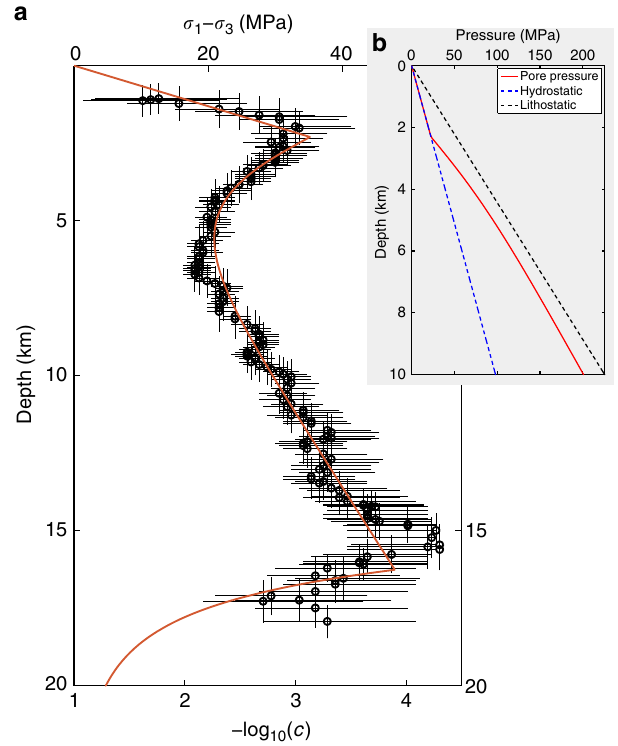
Fig. 4 Differential shear stress and the time delay before the onset of the power-law aftershock decay rate with respect to depth in California. a Logarithm of the most probable c -value for p = 1 with respect to the mean depth of the selected aftershocks within the 3 km depth bins (see all mainshocks in Fig. 2b). Error bars show the 95% Bayesian credibility regions for the c -value. The differential shear stress (red line) is derived from the Mohr – Coulomb theory using a coef fi cient of friction μ = 0.75, a porosity reduction mechanism at a depth of 2 km and a plastic fl ow law for wet quartzite (see “ Methods ” section and Table 1). b Evolution of pore (red), lithostatic (black), and hydrostatic pressures (blue) with respect to